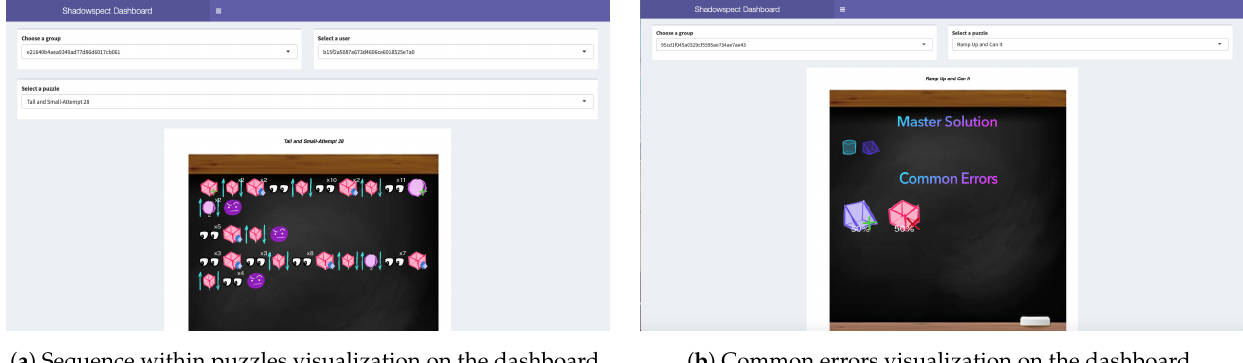
Figure 5. Two examples of our Shiny dashboard